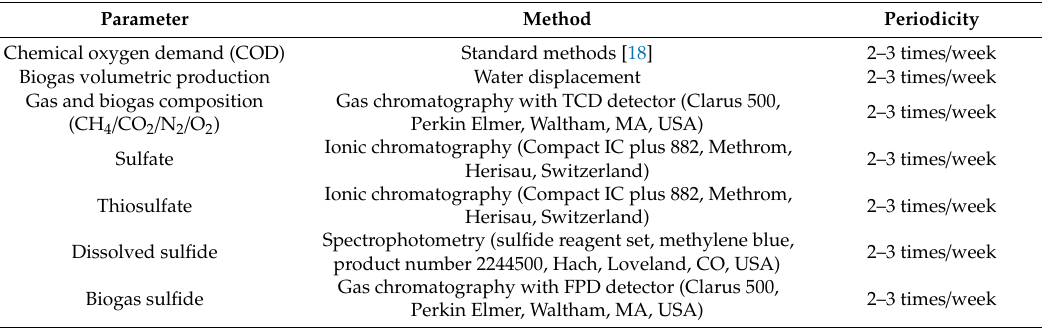
Table 1. Parameters determined during system operation.